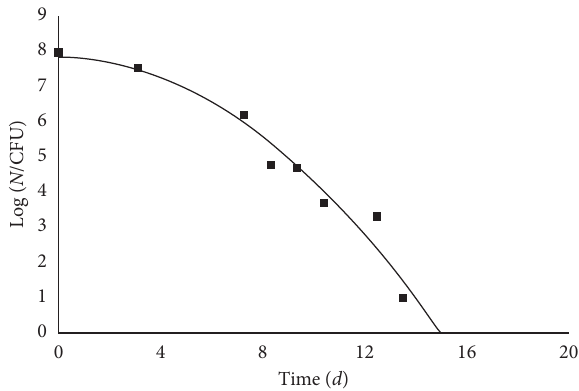
Figure 2: Decay trend of a planktonic microbial culture. The different trends correspond to various values of the parameter d (1, 2, 5, and 10 time-units 2 ) for δ � 2. The dashed curve on the left reflects a hypothetical growth trend leading to N max .